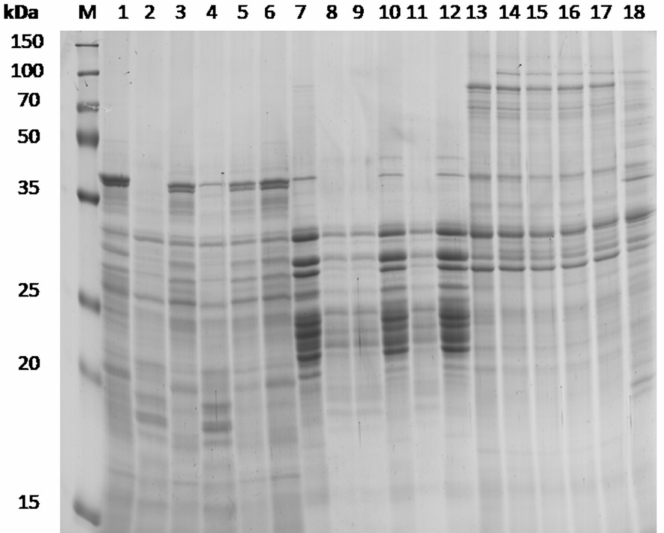
Figure 1. Representative SDS-PAGE analysis of gluten fractions extracted from a mixture of wheat flour and water (1:2), incubated for 24 h at 30 ◦ C, after inoculation with different LAB and yeast strains, which previously displayed positive proteolytic activity. M, protein marker; Lane 1, albumin fraction extracted from dough without inoculum (control); Lanes 2–6, albumin fractions extracted from doughs inoculated with microbial strains LQC 2320, 2474, 2520, 2469, and 10343, respectively; Lane 7, gliadin fraction extracted from dough without inoculum (control); Lanes 8–12, gliadin fractions extracted from doughs inoculated with microbial strains LQC 2320, 2520, 10343, 2469, and 2474, respectively; Lane 13, glutenin fraction extracted from dough without inoculum (control); Lanes 14–18, glutenin fractions extracted from doughs inoculated with microbial strains LQC 2320, 2469, 2474, 10343, and 2520,